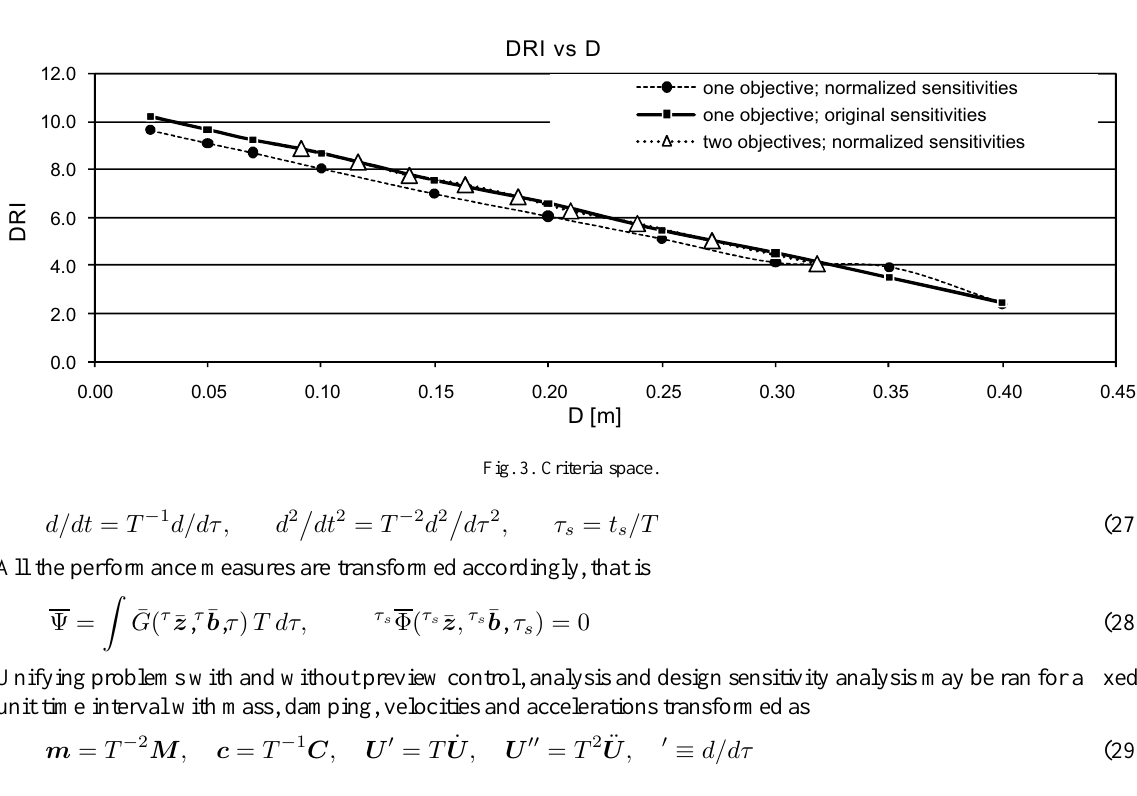
Fig. 2. Mass-model of spinal injury prevention.